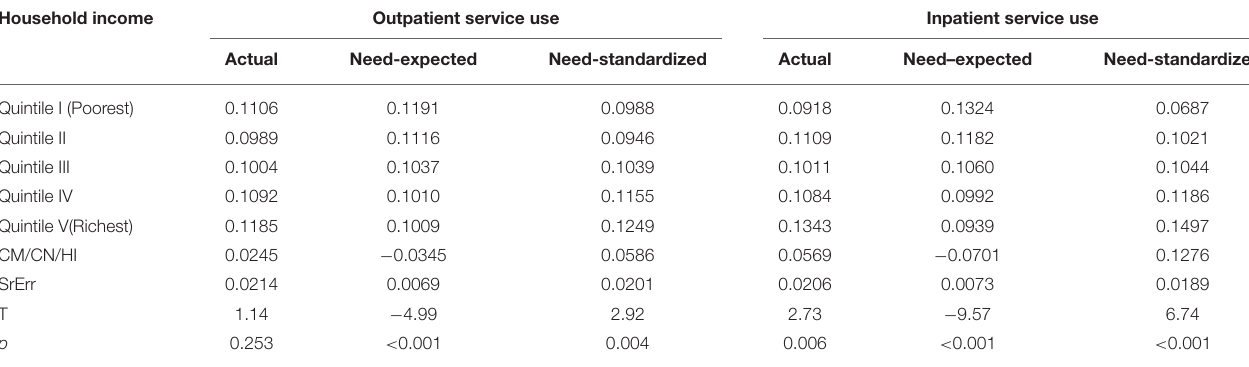
TABLE 2 | Distribution of actual, need-expected, and need-standardized use of outpatient and inpatient services across household income